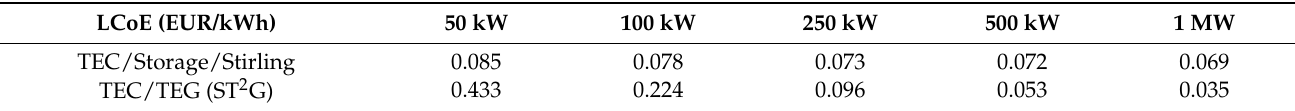
Table 5. Comparison of LCoE for the different options considered with the TEC integration and the use of BAF concentrator for small-size CSP.